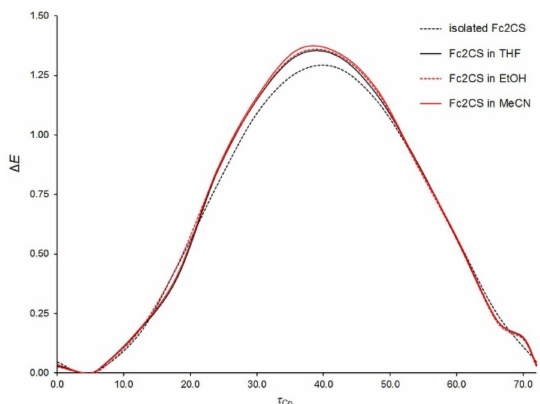
Figure 7. Energy of isolated and solvated Fc 2 CS molecules as a function of the dihedral angle describing the rotation of Cp-ring within the Fc-group ( τ Cp , in ◦ ). The energy ( ∆ E , in kcal mol − 1 ) is expressed relative to its lowest value in each medium.